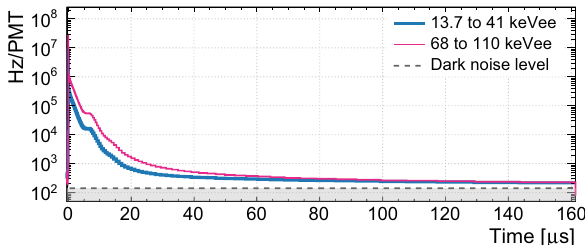
Fig. 2 The average pulseshapes in different energy windows, normal- ized to the number of events in each histogram and to the total number of PMTs. Approximately 200000 events were used for each energy window. The mean dark noise level of the PMTs is indicated by the dashed line. The pulseshapes do not reach the dark noise level even after 160 µ s due to an additional component of uncorrelated light as will be discussed in Sect.